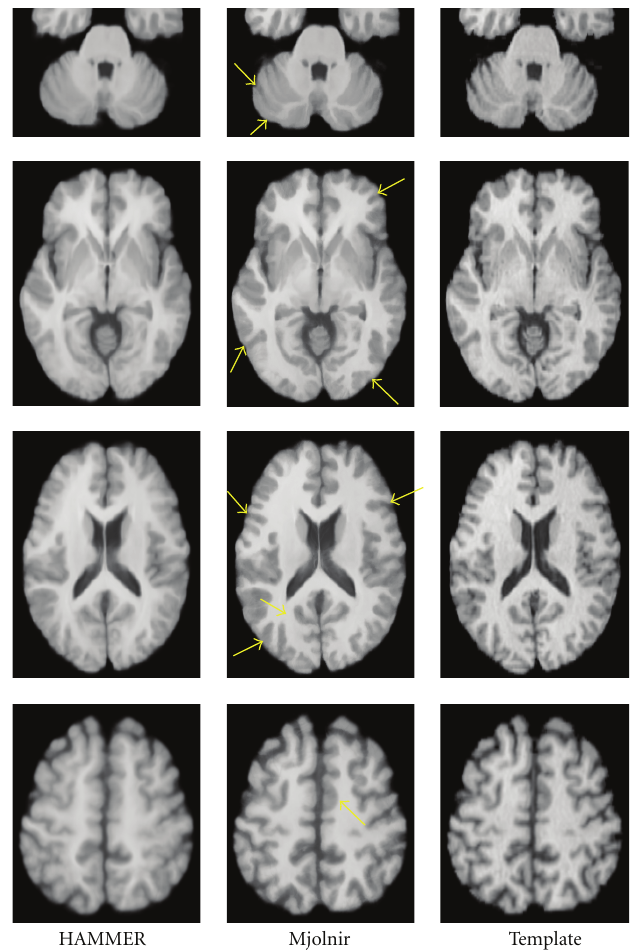
Figure 12: Four cross sections of the averages of 15 images registered to a 16th template image. The arrows highlight the most apparent regions of improvement in Mjolnir over